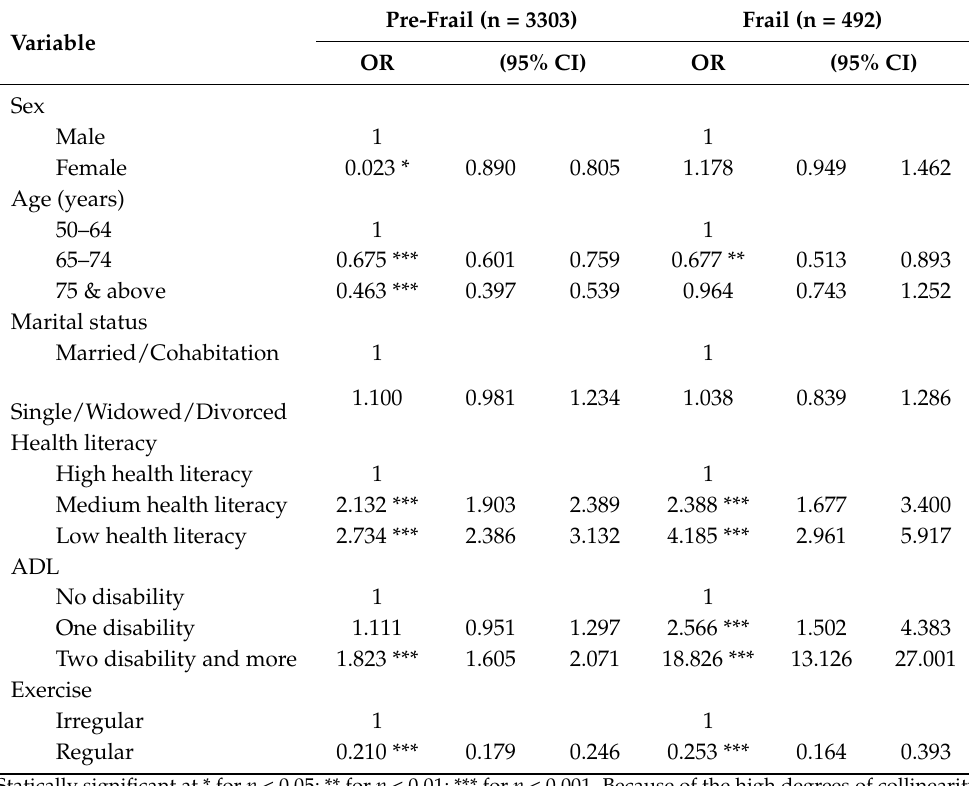
Table 3. Adjusted odds ratios (ORs) in multivariable logistic regression models of prefrailty and frailty for respondents of both sexes ( N =